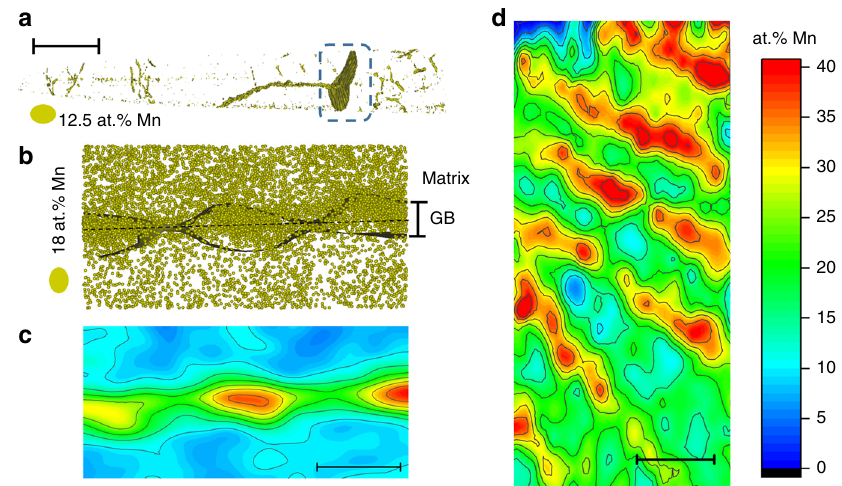
Fig. 4 APT analysis of a grain boundary decorated with Mn after 24 h at 240 °C. Atom probe tomography results: in a atom probe reconstruction and 12.5 at.% Mn iso-concentration surfaces. Scale bar, 80 nm. b A cross-section of the grain boundary. Scale bar, 2 nm. Every yellow sphere represents a Mn atom. c Chemical composition of the cross-section shown in b . Scale bar, 5 nm ( d ): an in plane concentration analysis of the grain boundary. Scale bar, 10 nm. The analysis in b – d refer to the grain boundary highlighted in a using a dashed blue